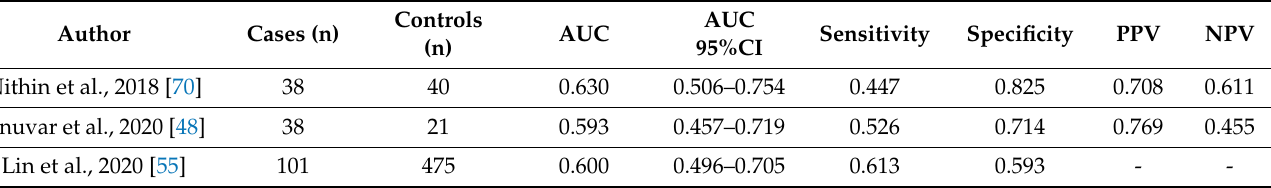
Table 6. Summary table of the performance of CA